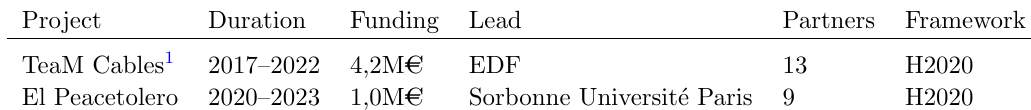
Table 1. Key figures for projects discussed.